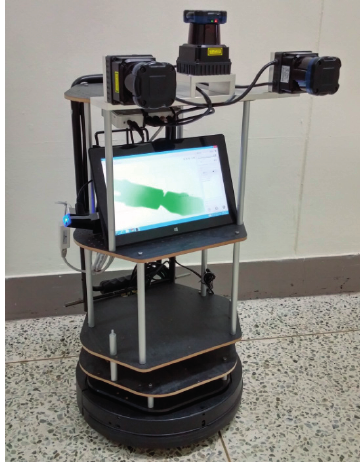
Figure 1. Kinematic 3D laser scanning system developed in this research